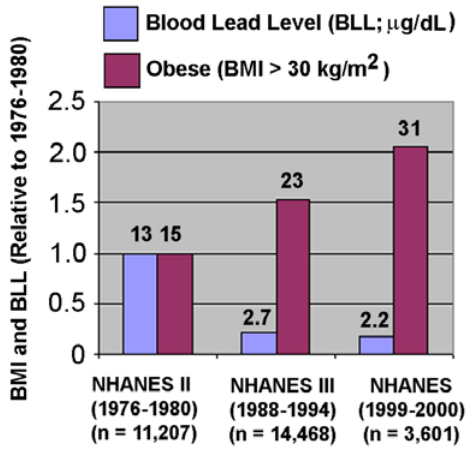
Figure 1. There is a negative association between blood lead levels and obesity from 1976 to